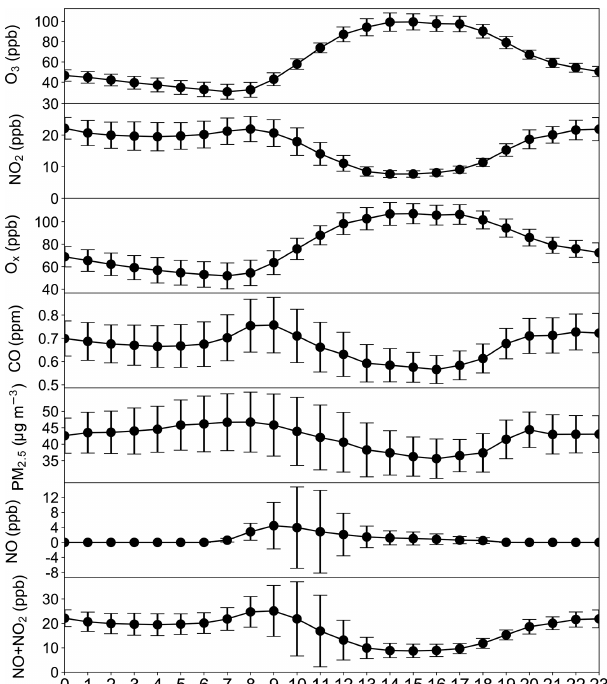
Figure 2. Average diurnal variations of air pollutants O 3 , NO 2 , O x , CO, PM 2 . 5 , NO and NO + NO 2 observed at the 77 stations in Guangdong during the two